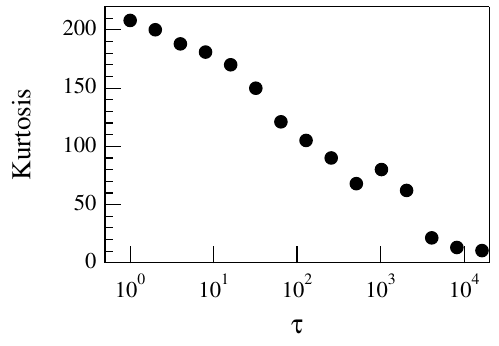
(t) versus the local Fig. 5. Dependence of the kurtosis of the synthetic mBm increments loc δX H(t) (τ) on the timescale τ Fig. 5. Dependence of the kurtosis of the synthetic mBm increments δX H ( t ) ( τ ) on the timescale τ .